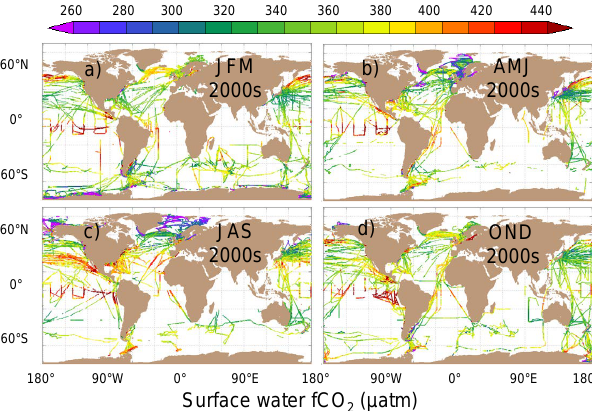
Figure 4. Seasonal distribution of surface water f CO 2 (µatm) for the months (a) January through March, (b) April through June, (c) July through September and (d) October through December in the years 2000 through 2009 in SOCAT version 3 for data sets with flags of A to E (after Bakker et al.,